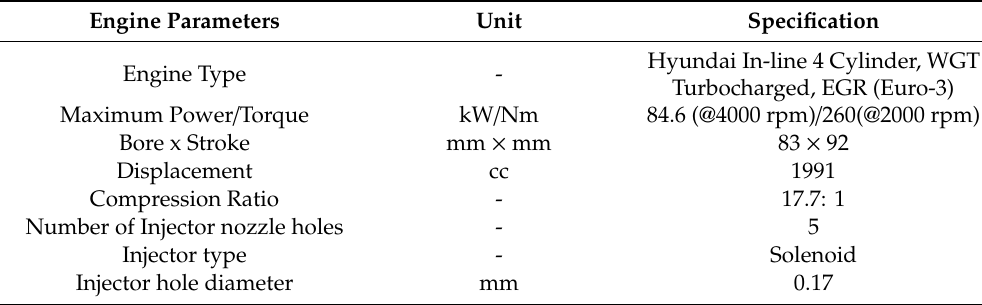
Table 2. Engine specification.